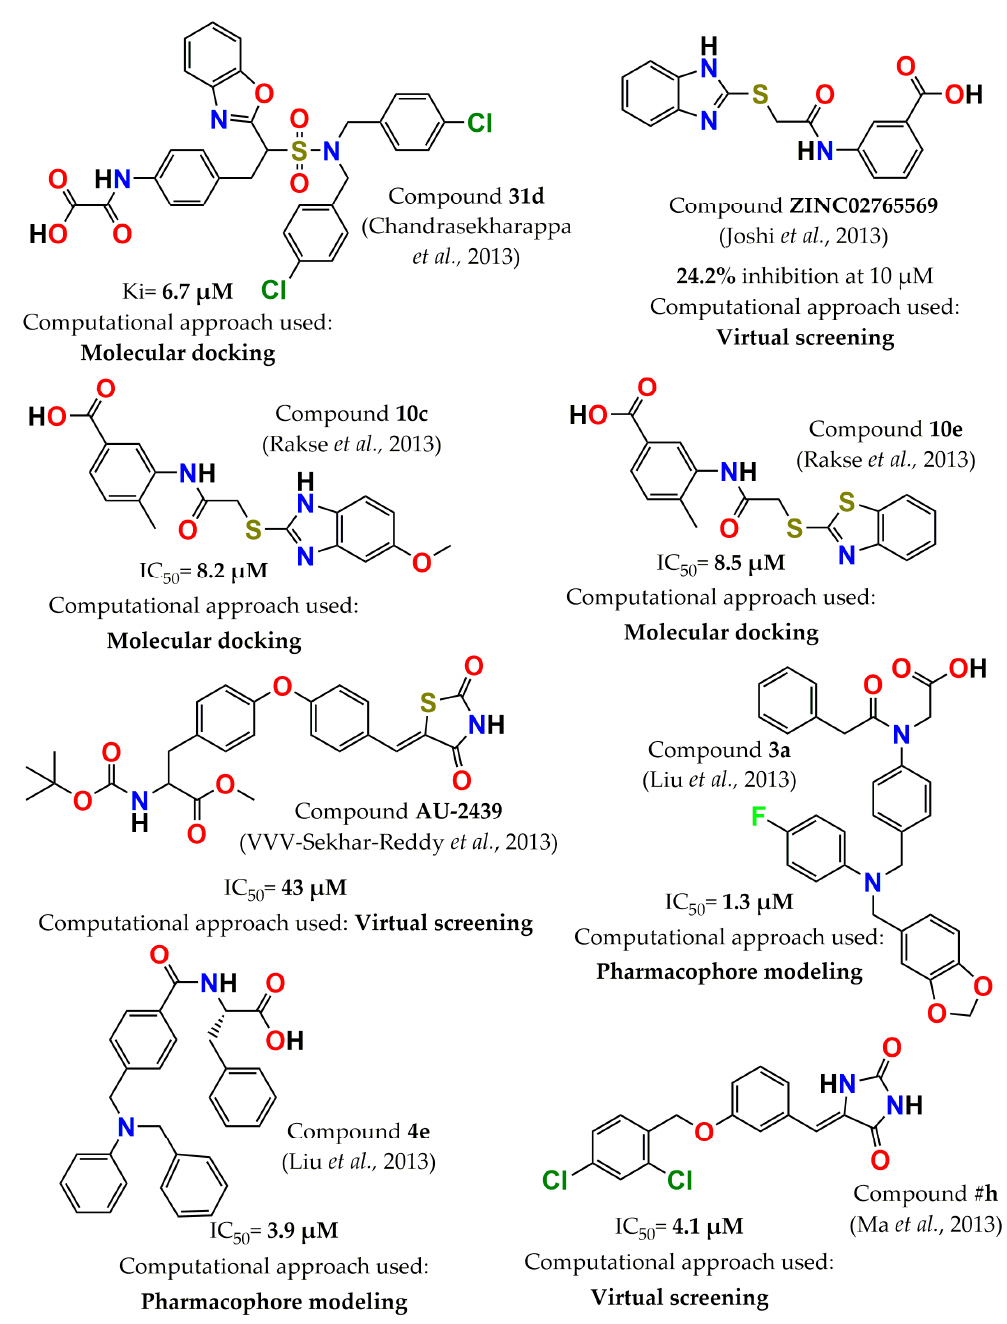
Figure 6. Structure of the most potent PTP1B inhibitors reported in 2013 discovered through com- putational approaches. tational